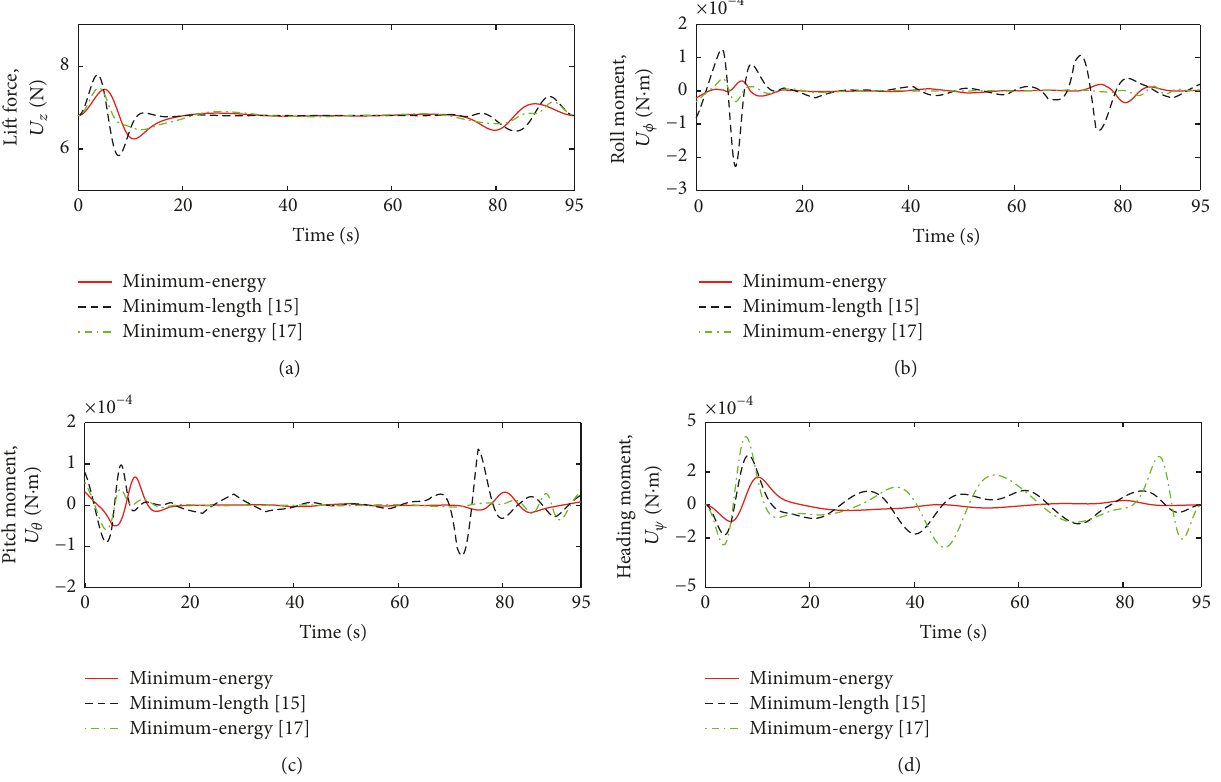
Figure 6: Induced efforts: (a) lift force and aerodynamical (b) roll and (c) pitch and (d) heading moments, respectively.